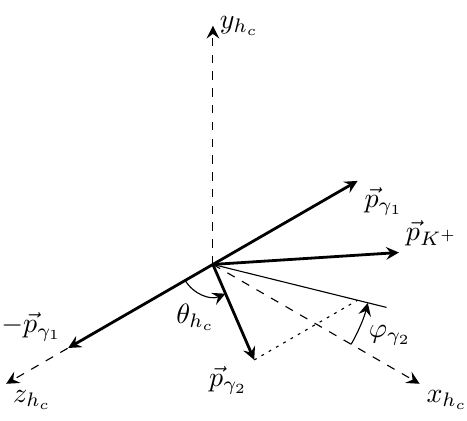
Figure 3 . De(cid:12)nition of the azimuthal angle ’